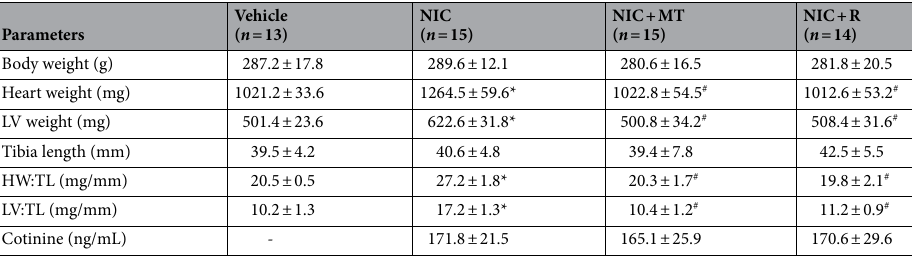
Table 1. End-point analysis of body weight, organ weight, and plasma cotinine in rats. All values are given as mean ± SEM for n = 13–15/group. HW heart weight, LV left ventricle, MT, NIC nicotine, NIC + MT nicotine + mitoTEMPO, NIC + R nicotine + resveratrol, TL tibia length. * p < 0.05 versus vehicle group. # p < 0.05 versus NIC group using one-way ANOVA with Tukey post hoc